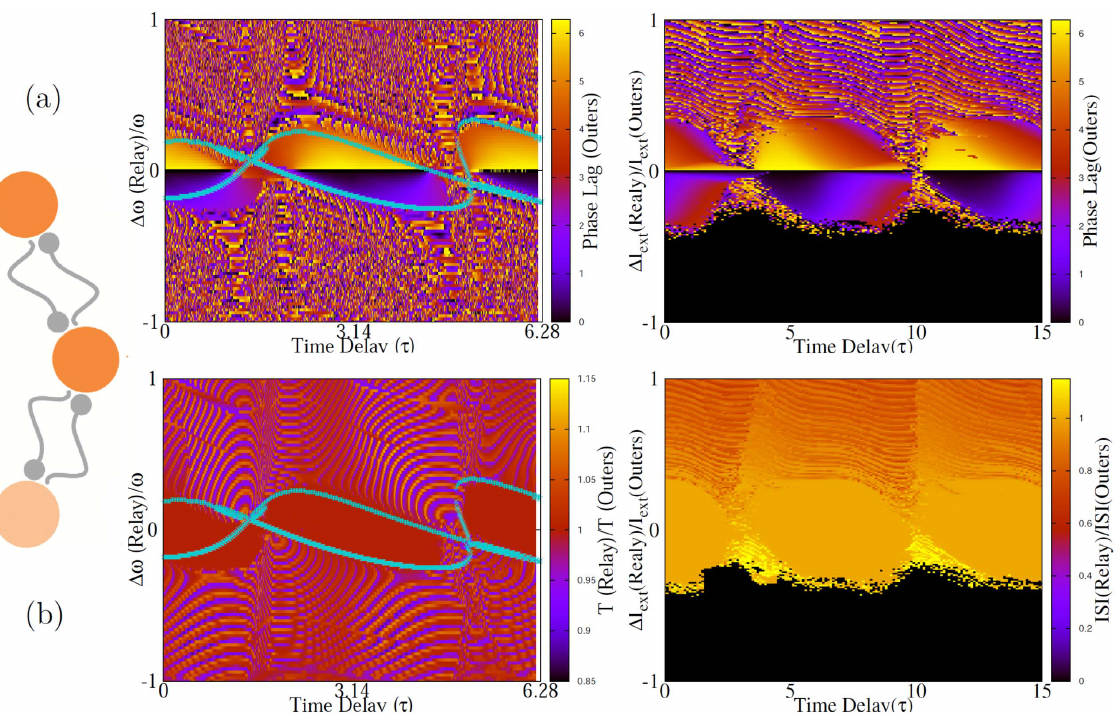
Fig. 7. Asymmetric relay system with inhomogeneous firing rates. When frequency mismatch is applied to one of the outer neurons, no synchronized state is seen, but for some range of mismatch 1:1 phase-locked states occur. (a) and (b) show the phase lag and ratio of the periods of outer neurons in the steady state, respectively. Blue lines are borders of 1:1 modes from analytic stability test. In the right, same results are shown for HH neurons.